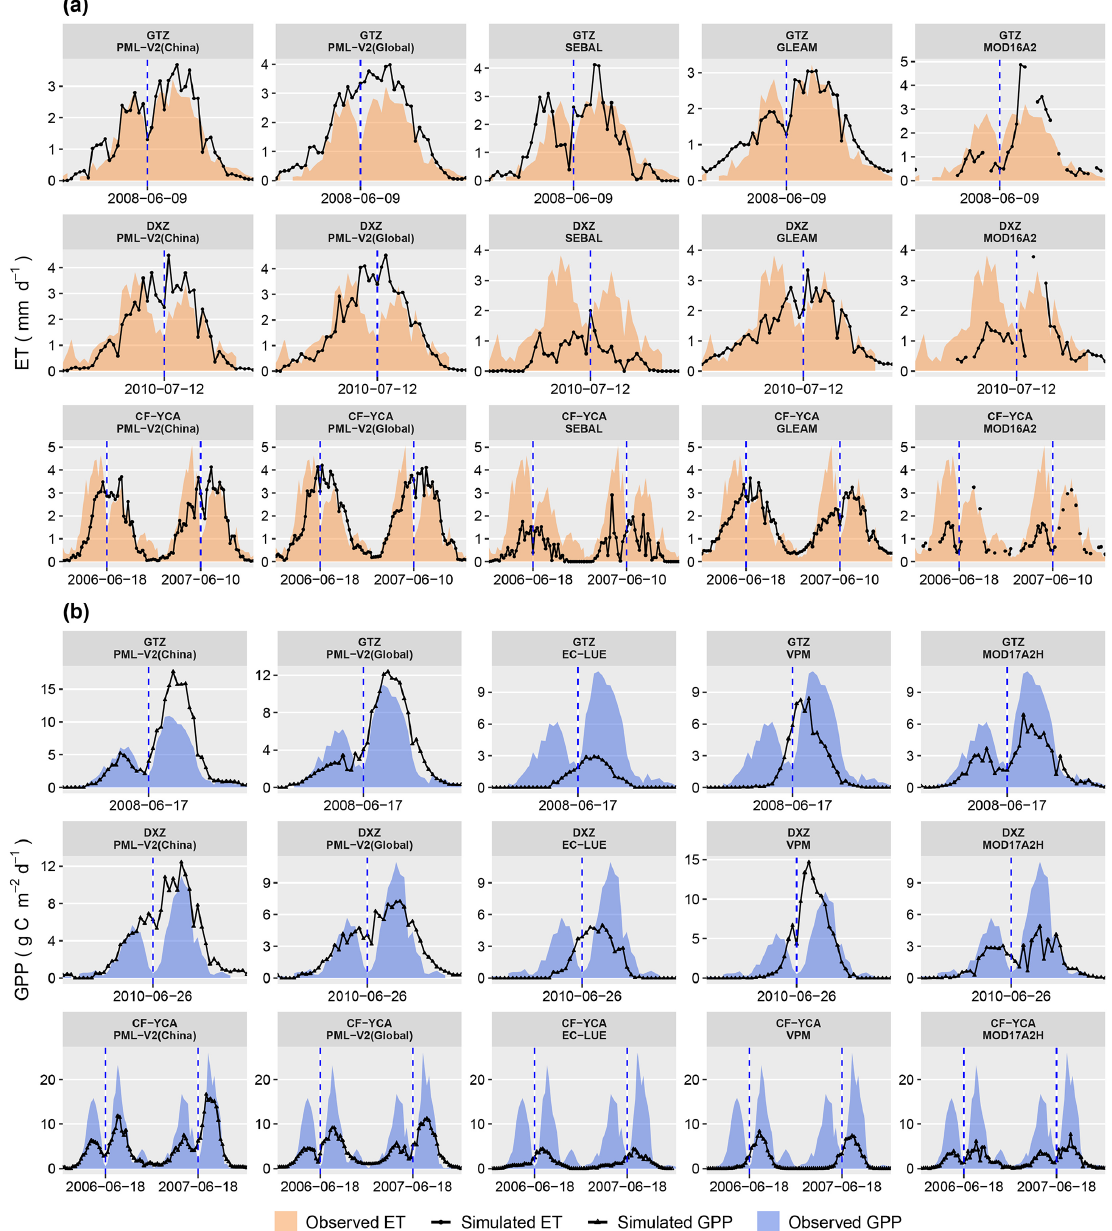
Figure 12. The intra-annual variation of (a) ET at three crop-rotation stations between those observed and simulated by PML-V2(China) in validation mode, PML-V2(Global), SEBAL, GLEAM, and MOD16A2, respectively; (b) GPP at three crop-rotation stations between those observed and simulated by PML-V2(China) in validation mode, PML-V2(Global), EC-LUE, VPM, and MOD17A2H, respectively. The blue dotted lines above pass through the lowest values between the two peaks of the observed ET or GPP per year. Note that all variables are averages every 8d, although units are per